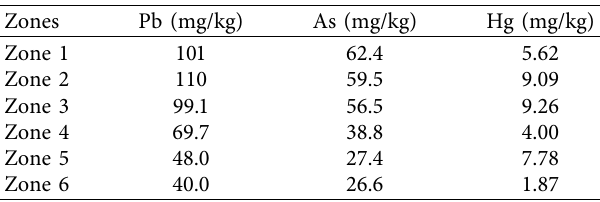
Table 4: Pb, As, and Hg concentrations in samples collected from Los Maitenes wetland soil.